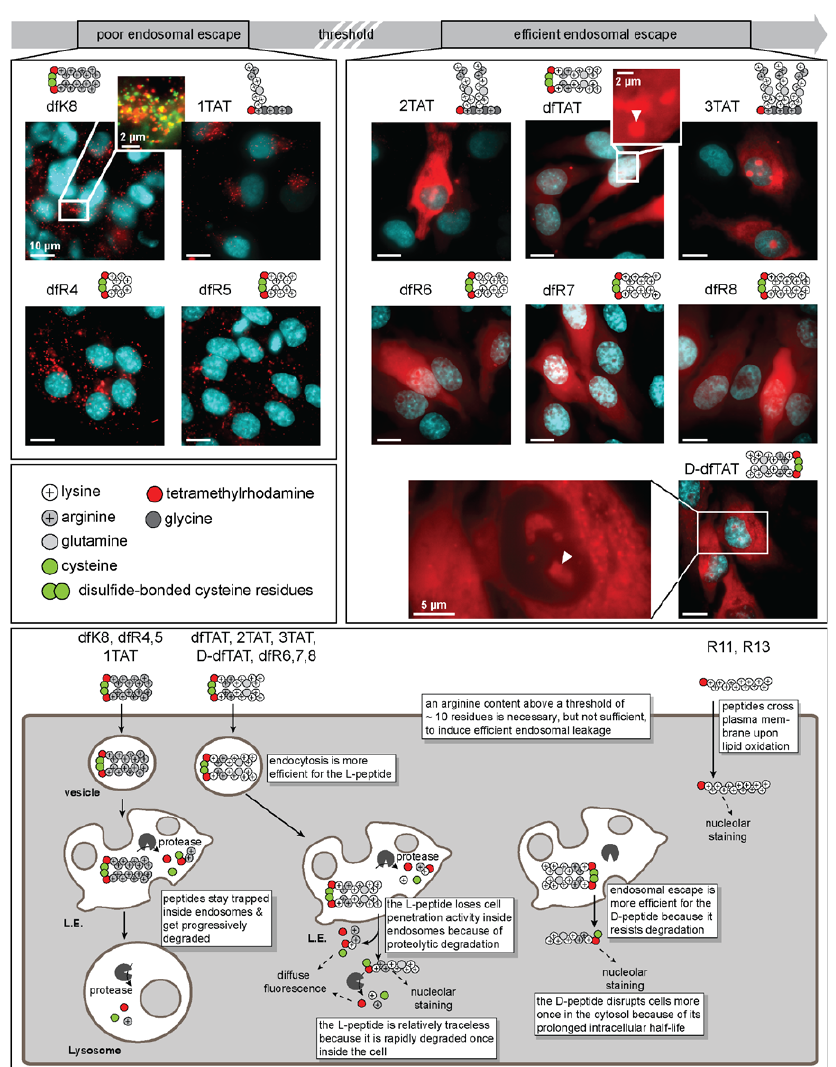
Figure 3. Active vs. inactive dfTAT variants. A threshold guanidinium density must be reached to achieve successful cytosolic penetration. Peptides such as dfK8, 1TAT, dfR4, and dfR5 do not meet the threshold guanidinium density, and as such, remained trapped within endosomes, as seen as puncta in the included fluorescence microscopy images. While trafficking through the endocytic pathway, these peptides become progressively more degraded. However, once a peptide has met or exceeded the guanidinium threshold, successful cytosolic penetration is obtainable (nucleolar staining is used to confirm that the fluorescence signal is intracellular and is highlighted with white arrows). This is shown as fluorescence microscopy images over 2TAT, dfTAT, 3TAT, dfR6, dfR7, and dfR8. Owing to susceptibility to proteolysis, L -peptides are degraded along the endocytic pathway. This results in a decreased activity upon reaching the late endosome. However, one favorable outcome of this characteristic is that upon successful cytosolic penetration, L -peptides are relatively traceless, as they are also rapidly degraded within the cell. Notably, peptides that are protease resistant (e.g., D -amino acid peptides) are less efficient at inducing endocytosis, but more efficient at causing endosomal escape relative to L -amino acid counterparts. These peptides remain intact and localize to the nucleoli of the cell for a prolonged period of time (>3 days; in contrast, L -peptides are fully degraded within 3 h, leading to a disappearance of nucleolar staining). As a drawback, D -peptides disrupt cells more once in the cytosolic space, owing to the prolonged intracellular half-life. Finally, linear, non-branched peptides that have a high guanidinium content (e.g., R11, R13) enter cells by direct plasma membrane translocation. In our hands, this process is dependent on culture conditions, membrane oxidation, and lipid peroxidation. Why branched and linear species differ in their internalization routes remains unclear. This nonetheless suggests that arginine content alone is not sufficient to confer endosomolytic activity, and that other chemical or structural features must be at play in compounds such as